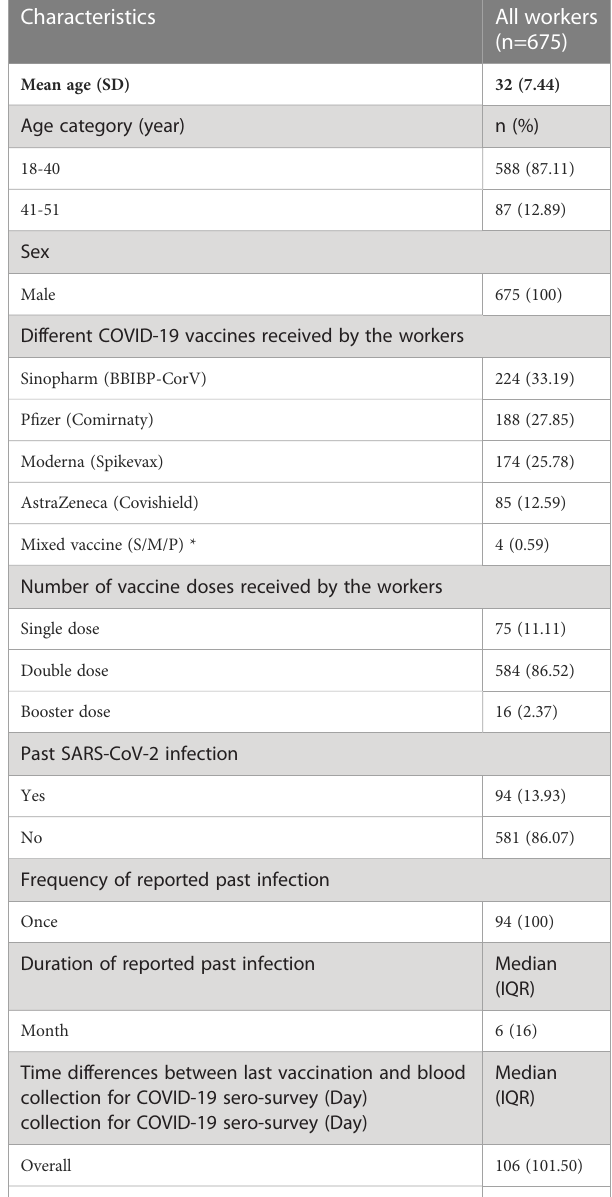
TABLE 1 Age, sex, vaccination, and SARS-CoV-2 infection history of the migrant workers.